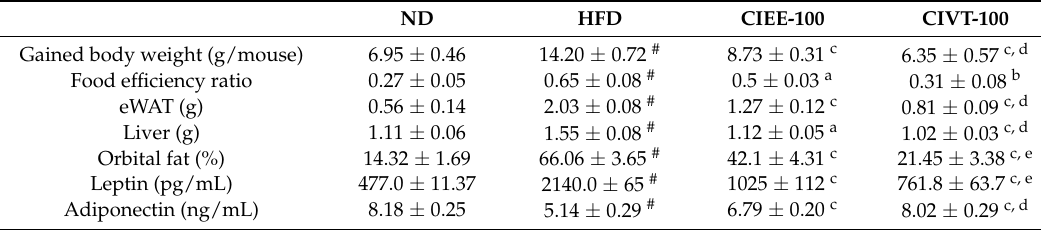
Table 2. Comparison of anti-obesity effects of CIEE and CIVT.